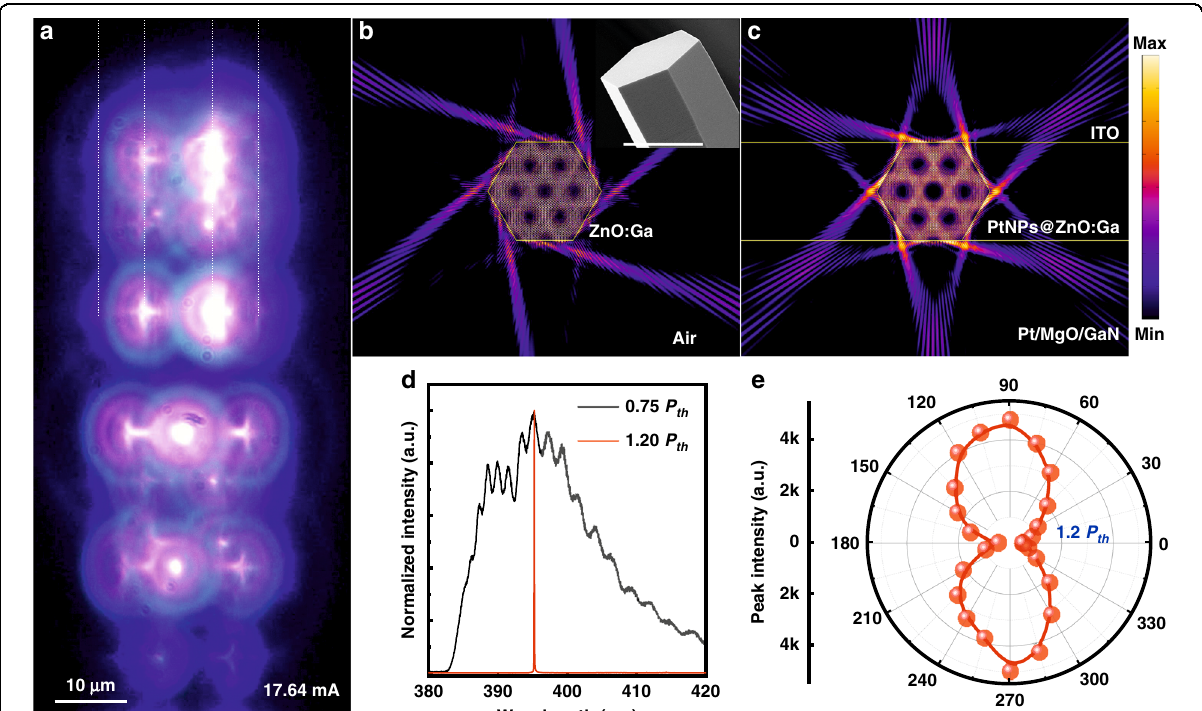
Fig. 2 Device characteristics of the laser emission from the fabricated microlaser at the threshold. a Optical microscopic CCD image of the emission from the fabricated device. b Finite-element simulations showing the standing-wave electric- fi eld pattern of a bare ZnO:Ga wire with hexagon-shaped cross section under an optical resonant mode. Inset: SEM observation of a bare ZnO:Ga wire, that showing the hexagon-shaped cross section (Scale bar: 15 μ m). c The simulated resonant standing-wave electric- fi eld pattern within the cross-section of the fabricated n- PtNPs@ZnO:Ga MW/Pt/MgO/p-GaN emission device structure. d Normalized EL emission spectra of the fabricated device for two injection currents below (0.75 P th ), and above (1.20 P th ) the laser threshold, respectively. e Polarization properties of the laser emission for an operating current above the threshold (~1.20 P th ). The experiment EL data are symbolized by the red dots and the red solid line is the fi tting